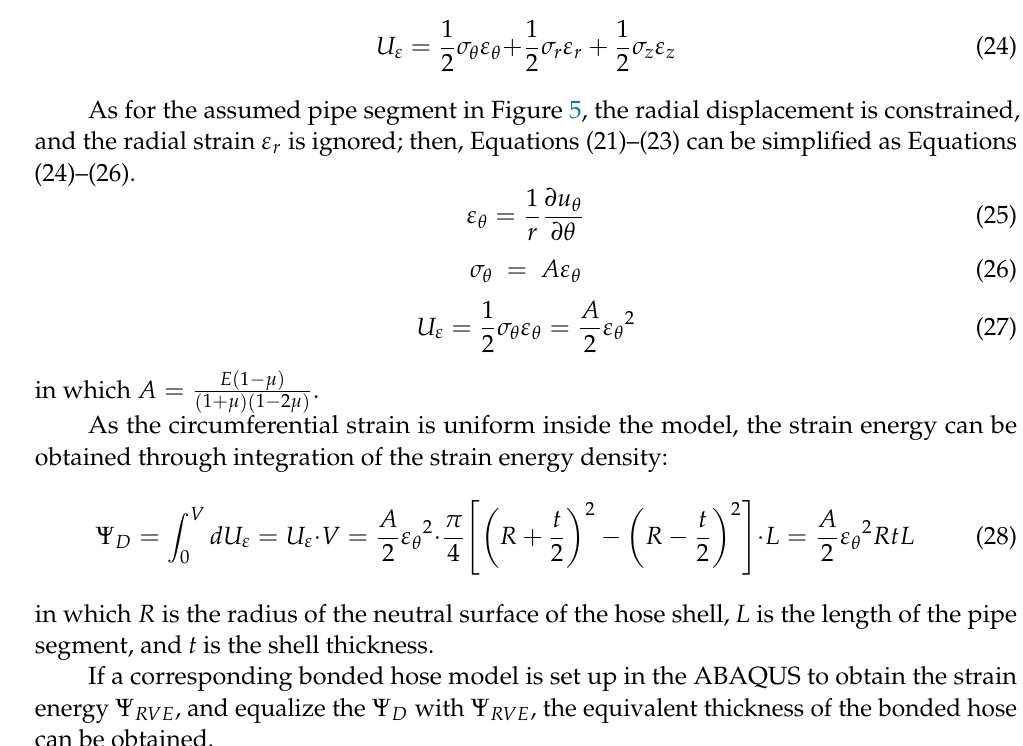
( a ) ( b ) Figure 7. Simplified FEM model for the strain energy calculation: ( a ) general configuration; ( b ) boundary condition. In the FEM model, the boundary conditions replicate those in Figure 6. Figure 7 shows the applied boundary conditions in the present FEM model. 4. Model Validation A 12 ‐ inch hose was selected to validate the proposed model. It has an inner diameter of 152.4 mm and an outer diameter of 194 mm. Each ply is 0.7 mm thick, and it crosses at +/ − 45° with respect to the longitudinal axis of the hose. The inner composite layer has 10 pairs of +/ − 45° plies, and the outer composite layer has 4 pairs of +/ − 45° cord plies. The steel wire is 4 mm in radius, and the helix has a diameter of 176.4 mm and a helix angle of 80°. The structural parameters of the hose are listed in Table 1. Table 1. Structural parameters of the hose. Composite Laminate Inner Radius (mm)